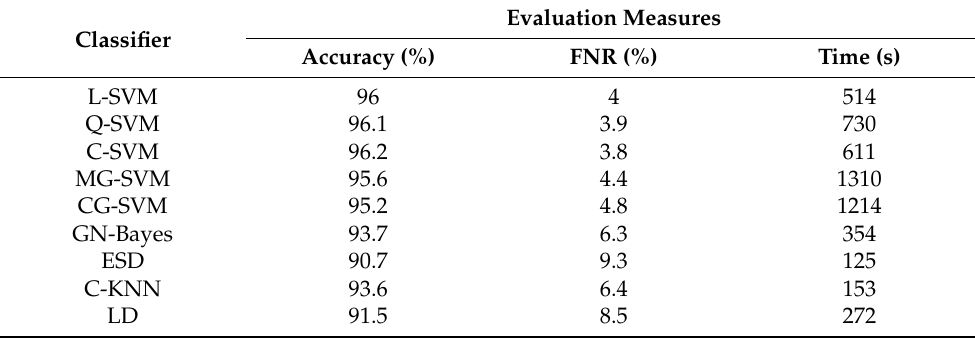
Table 1. Stomach disease classification results using deep CNN features fusion.